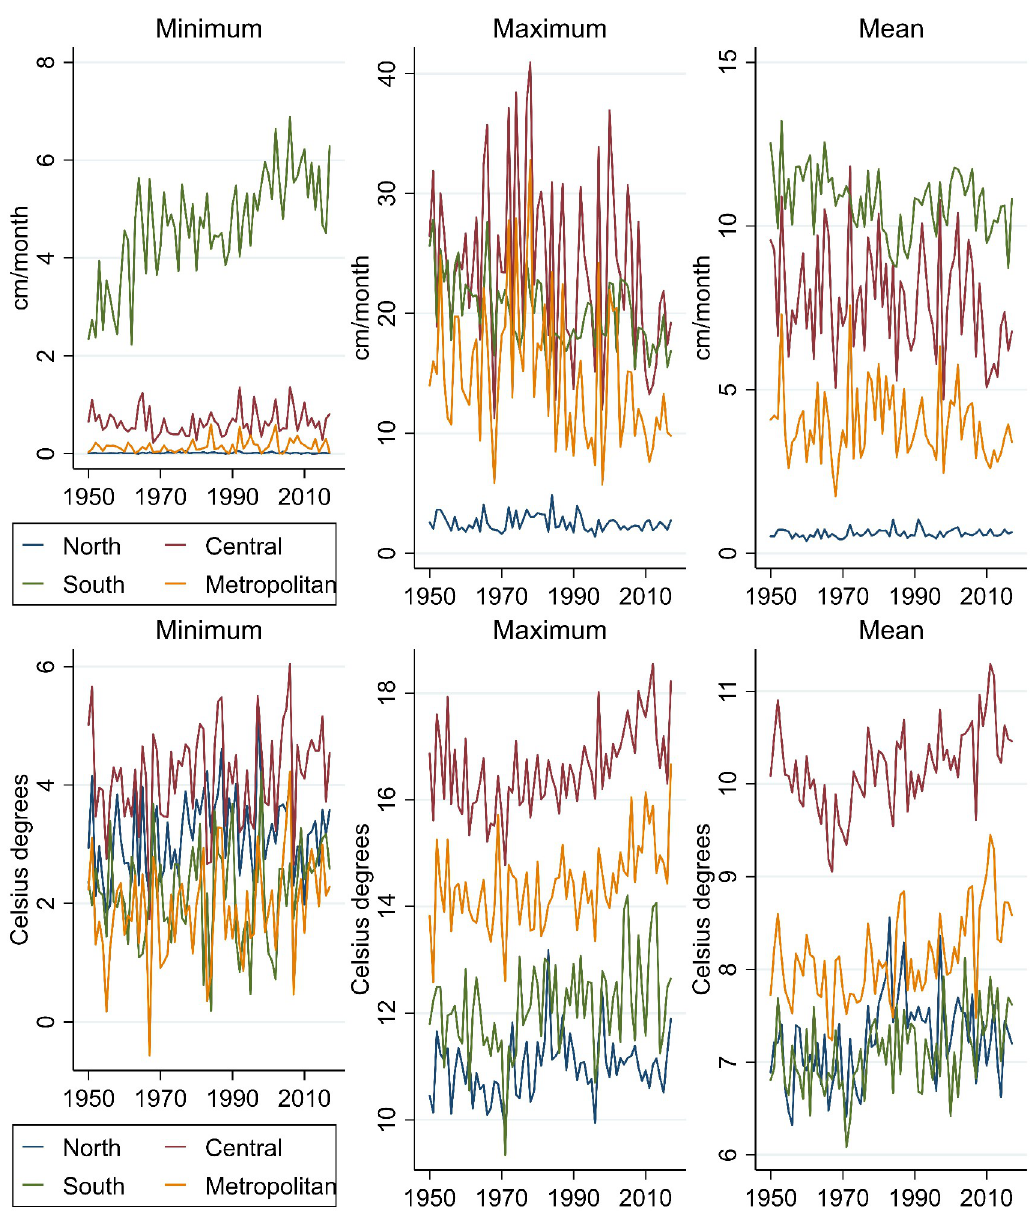
Fig 2. The evolution of the yearly precipitation and temperature (weighted by the surface area of each region) for each macrozone during the period 1950–2017. Minimum, Maximum and Mean values are from January to December of each